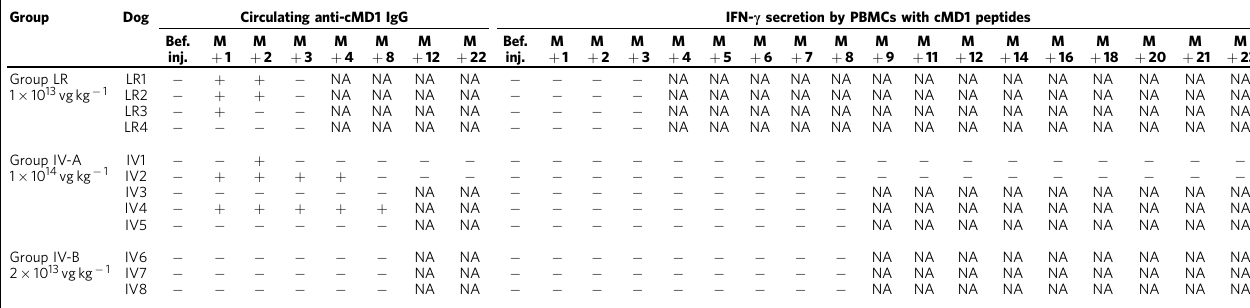
Table 3 | Anti-cMD1-specific circulating IgG antibodies and anti-cMD1 specific IFN- g secretion from PBMCs of GRMD dogs injected with rAAV2/8-Spc5.12-cMD1 by the LR or the IV route. Group Dog Circulating anti-cMD1 IgG IFN- c secretion by PBMCs with cMD1 peptides Bef. inj.